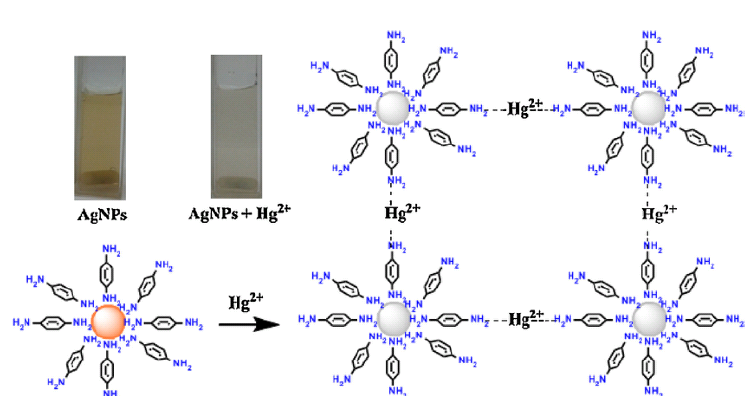
Fig. 11. Scheme for interaction of Hg 2+ by p-PDA capper AgNPs. Reprinted with permission from ref.82 Copy right 2013 Elsevier.